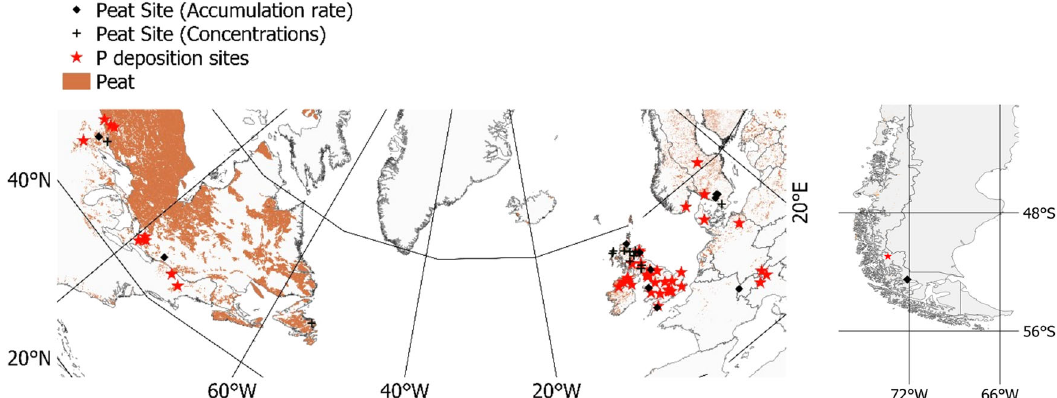
Fig. 1 Location of bog stoichiometric pro fi les and monitoring sites for P deposition. We collated P, N and C concentration data for 23 mid-latitude sites (crosses; Supplementary Figs. 1 and 2), of which 11 also provided accumulation rates (diamonds). Red stars represent the locations of regional monitoring stations for P deposition used in the analysis, originally reported by Tipping et al. 54 and Brahney et al. 19 . The distribution of peatlands is taken from the PEATMAP of Xu et al.